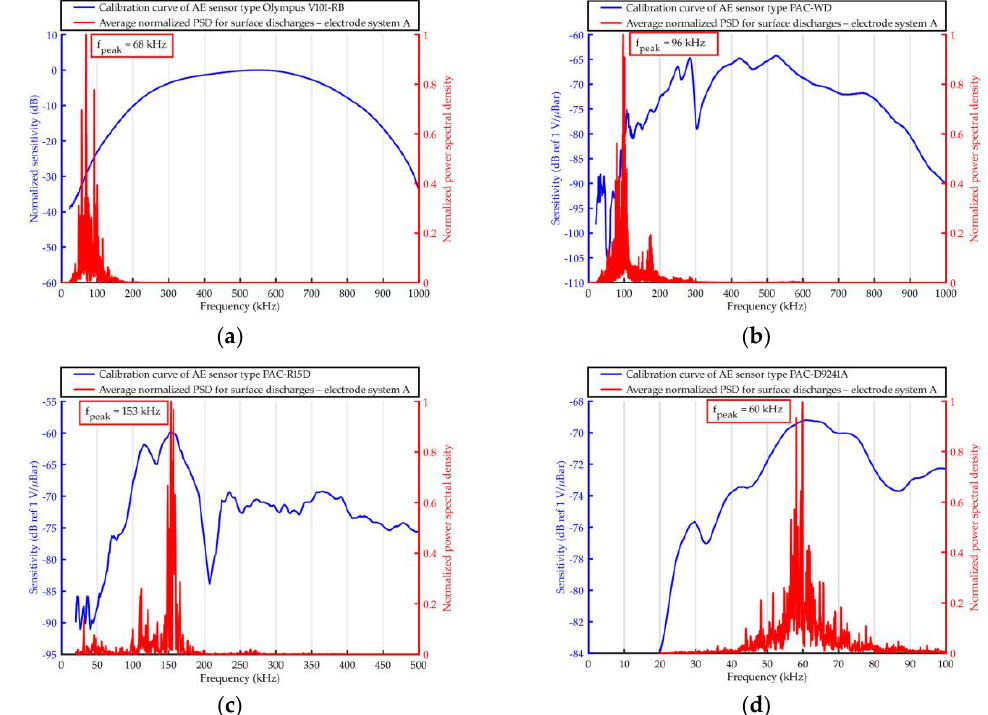
Figure 11. Average normalized power spectrum density (PSD) determined for acoustic emission (AE) signals emitted by surface discharges (generated in electrode system A) and registered with the use of ultrasonic sensor type: ( a ) Olympus V101-RB, ( b ) PAC WD, ( c ) PAC R15D, and ( d ) PAC D9241A.